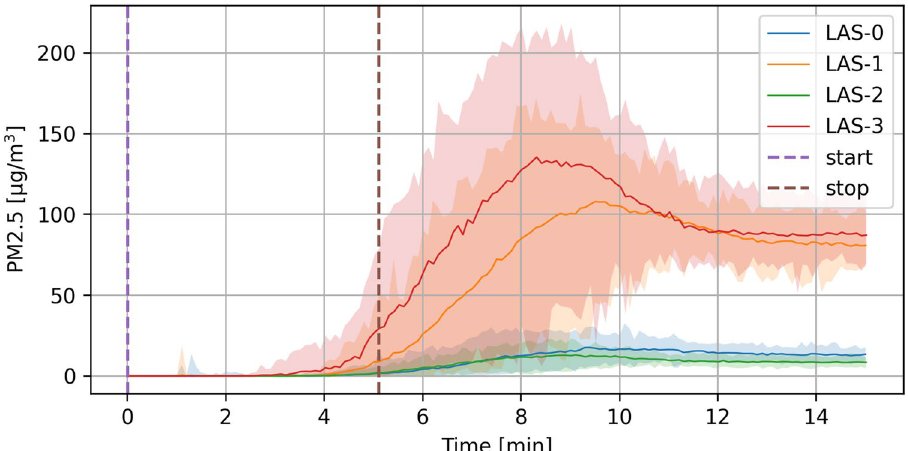
Figure 11. Example data of 40 repeated experiments. Solid lines show the mean concentration at each point in time. The shaded areas indicate where 95% of the actual measurements lie. Aerosol emission starts at the purple dashed line and stops at the brown dashed line. LAS-0 and -1 were at a 1 m distance, and LAS-2 and -3 at 2.5 m. LAS-0 and -2 had tightly fitting FFP2 masks on, LAS-1 a loosely fitting FFP2, and LAS-3 no mask at